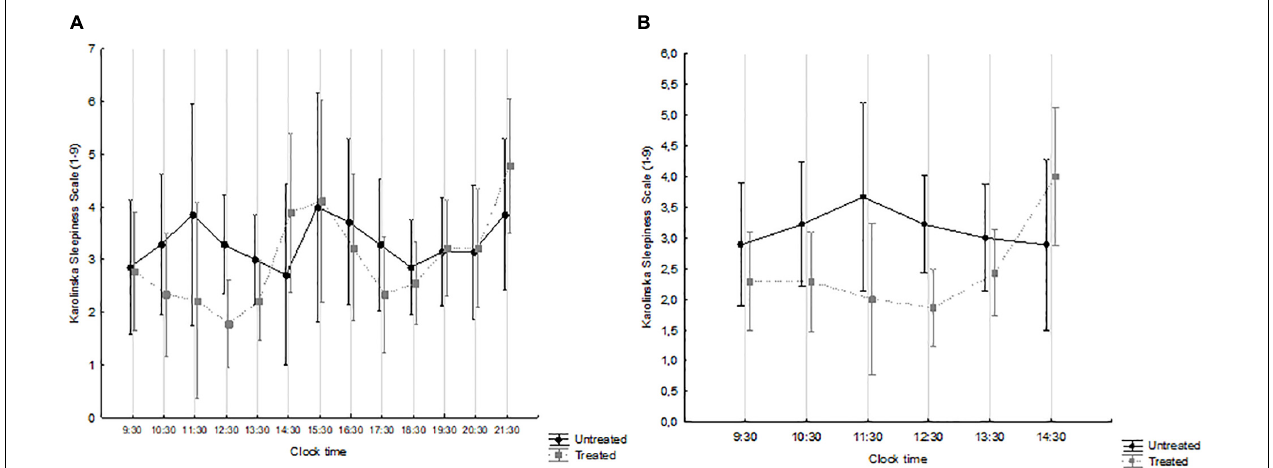
FIGURE 2 | Karolinska Sleepiness Scale (KSS) scores, from 09:30 to 21:30 (A) and from 09:30 to 14:30 (B) in patients treated with Luminette R (cid:13) light glasses plus short-wavelength filter glasses (gray squares and broken line) and untreated patients (black circles and full line). (A) Time: F = 1.932, p = 0.034; treatment: F = 0.481, p = 0.499; interaction time × treatment: F = 1.164, p = 0.313. treated n = 9; untreated n = 7. (B) Time: F = 1.210, p = 0.310; treatment: F = 2.342, p = 0.141; interaction time × treatment: F = 2.661, p = 0.026. treated n = 14; untreated n = 9.